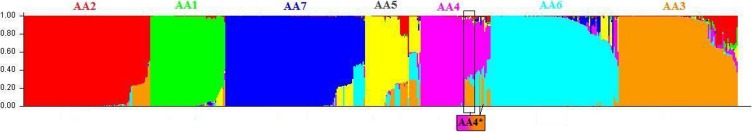
Genetic structure of Asian/American genotype obtained using the STRUCTURE program using admixture model.Sublevel cluster analysis of the dataset of 552 strains of Asian/American genotype was carried out using STRUCTURE program. The presence of seven distinct lineages are depicted as a bar plot. The seven lineages are AA1 (green), AA2 (red), AA3 (orange), AA4 (pink), AA5 (yellow), AA6 (cyan) and AA7 (blue). These lineages correspond to the clusters obtained using the NJ-based tree (Fig. 1) and have been colour-coded. The STRUCTURE program resolved the cluster assignments of admixed strains of all the seven lineages in general and that of AA4 lineage, in particular. The admixed strain of AA4 cluster, denoted as AA4*, are found to group with the strains of AA3 lineage in the NJ tree, have >0.50 membership for AA4 (indicated in pink) subpopulation and ∼0.35 membership for AA3 (orange) subpopulation.